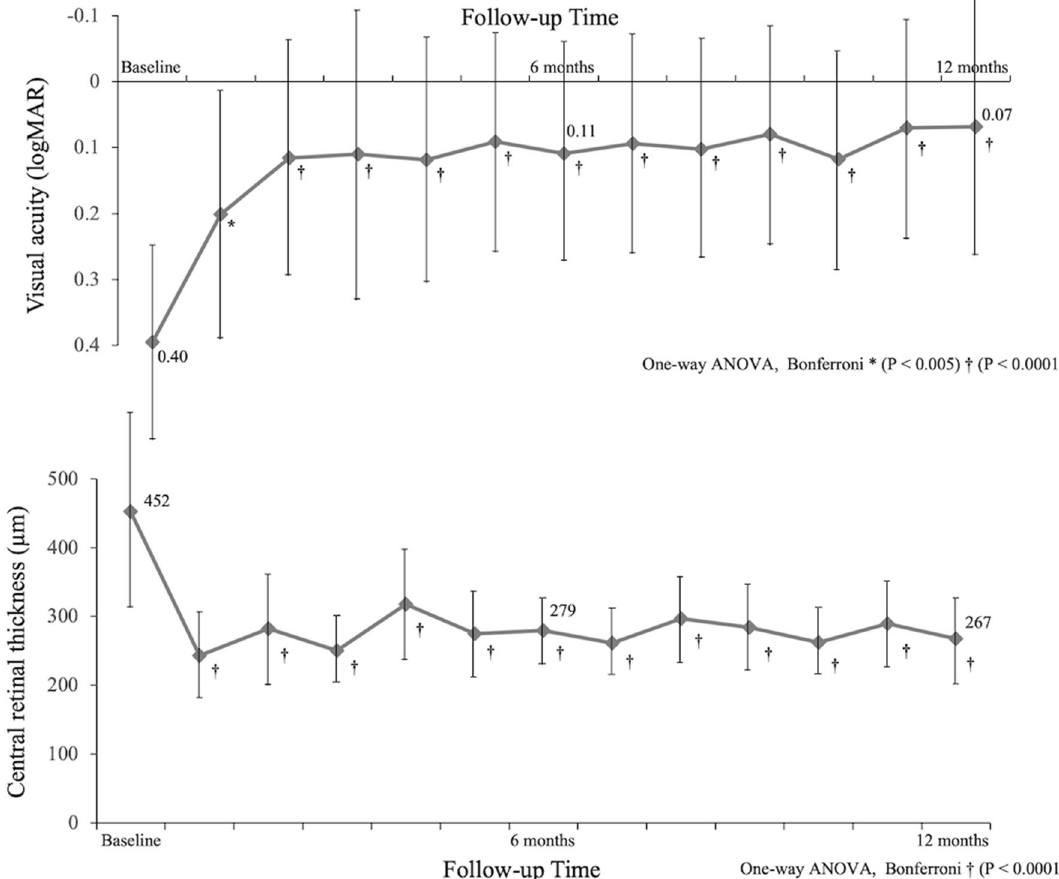
Figure 1. (Top) Time course of changes in visual acuity in patients with branch retinal vein occlusion (BRVO) for 12 months. Intravitreal ranibizumab injection (IVR) treatment significantly improved visual acuity. (Bottom) Time course of changes in central retinal thickness in patients with BRVO for 12 months. IVR treatment significantly improved central retinal thickness from 1 month after